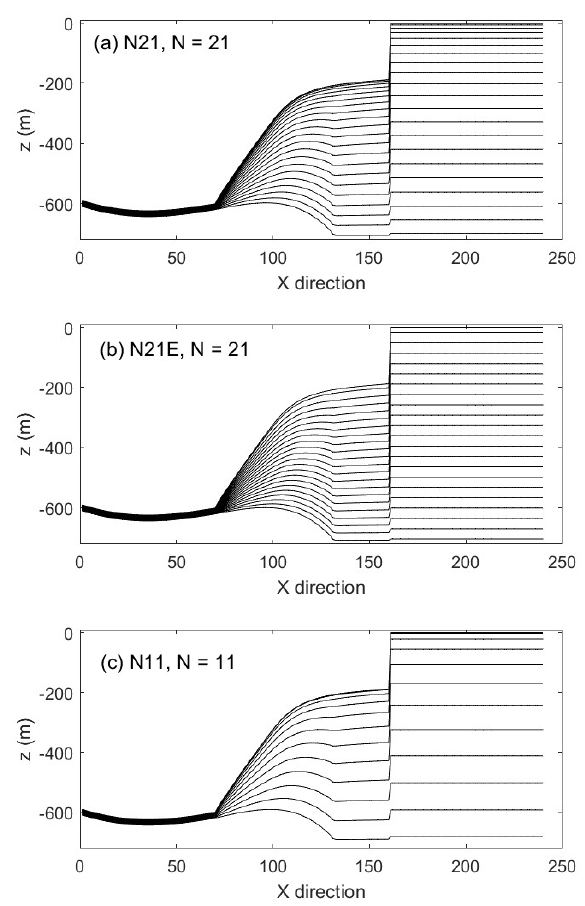
Figure A6. Stratification structure of experiment (a) N21, (b) N21E and (c) N11 with different vertical resolution. N is the vertical lay- ers used in the ocean model.